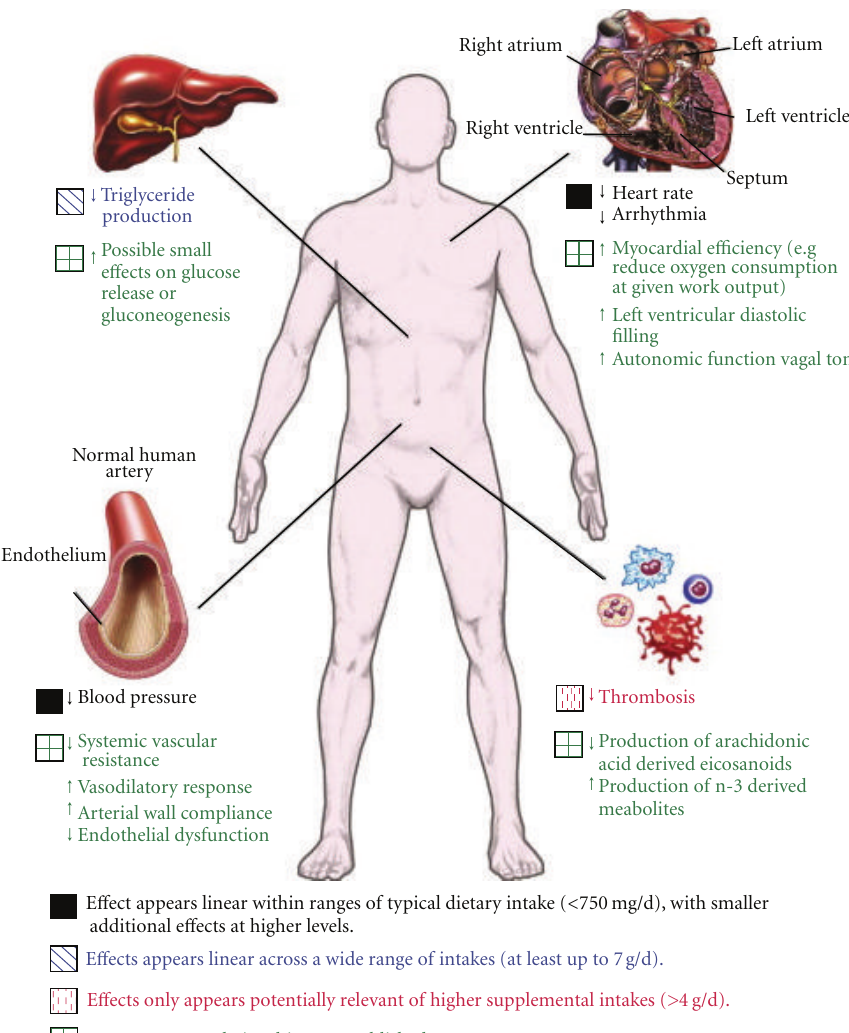
Figure 2: Physiological e ff ects of n-3 PUFA that might influence cardiovascular disease (CVD) risk [9].